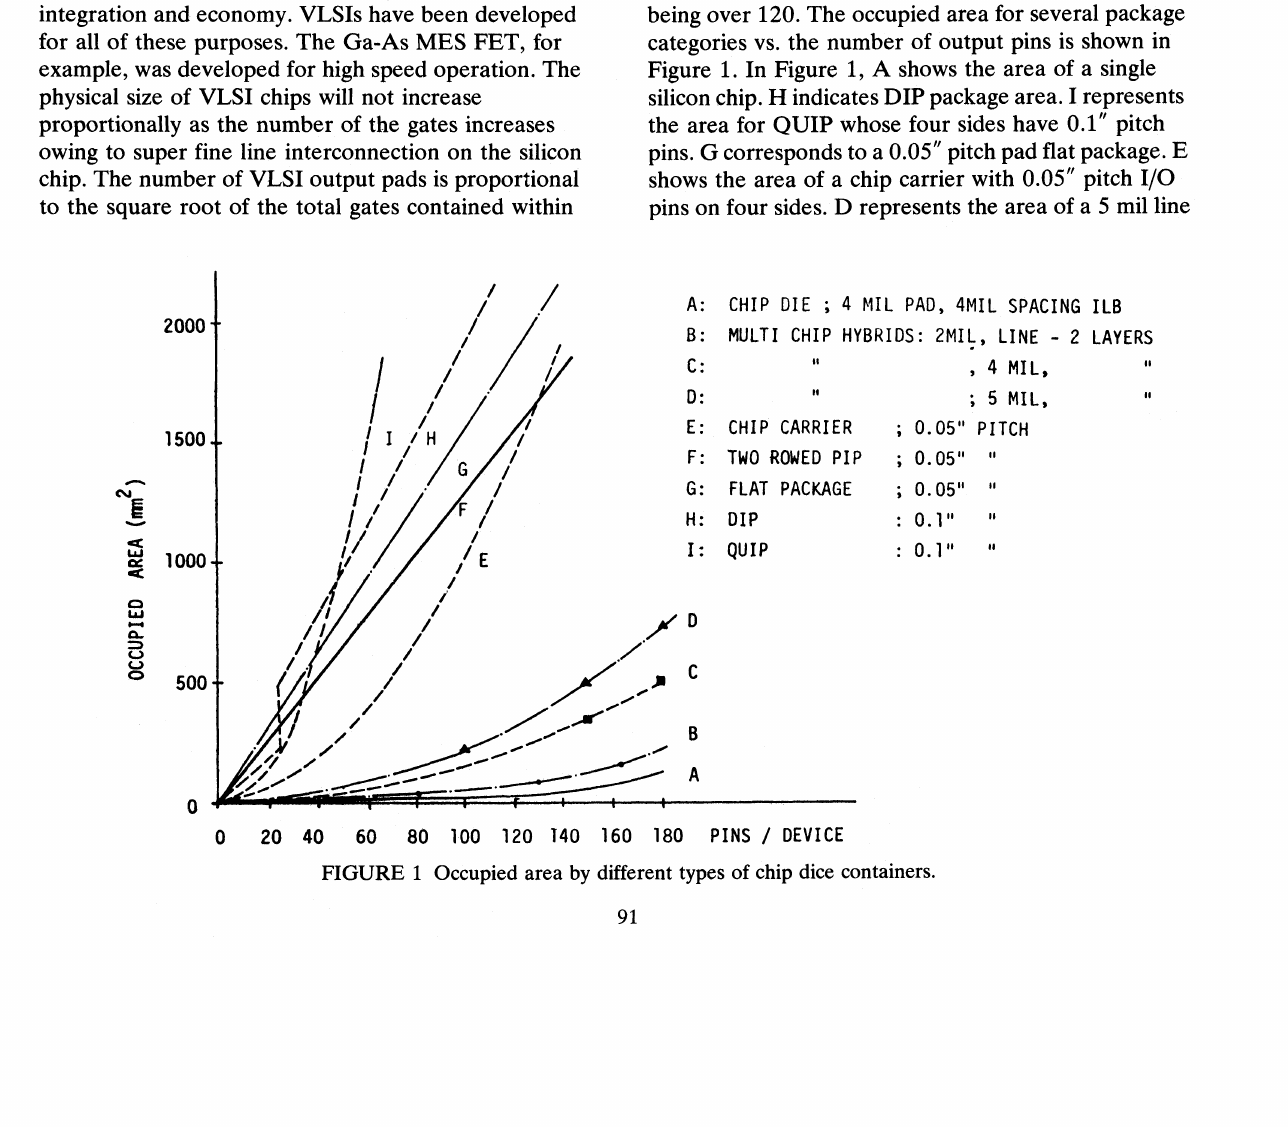
Occupied area by different types of chip dice